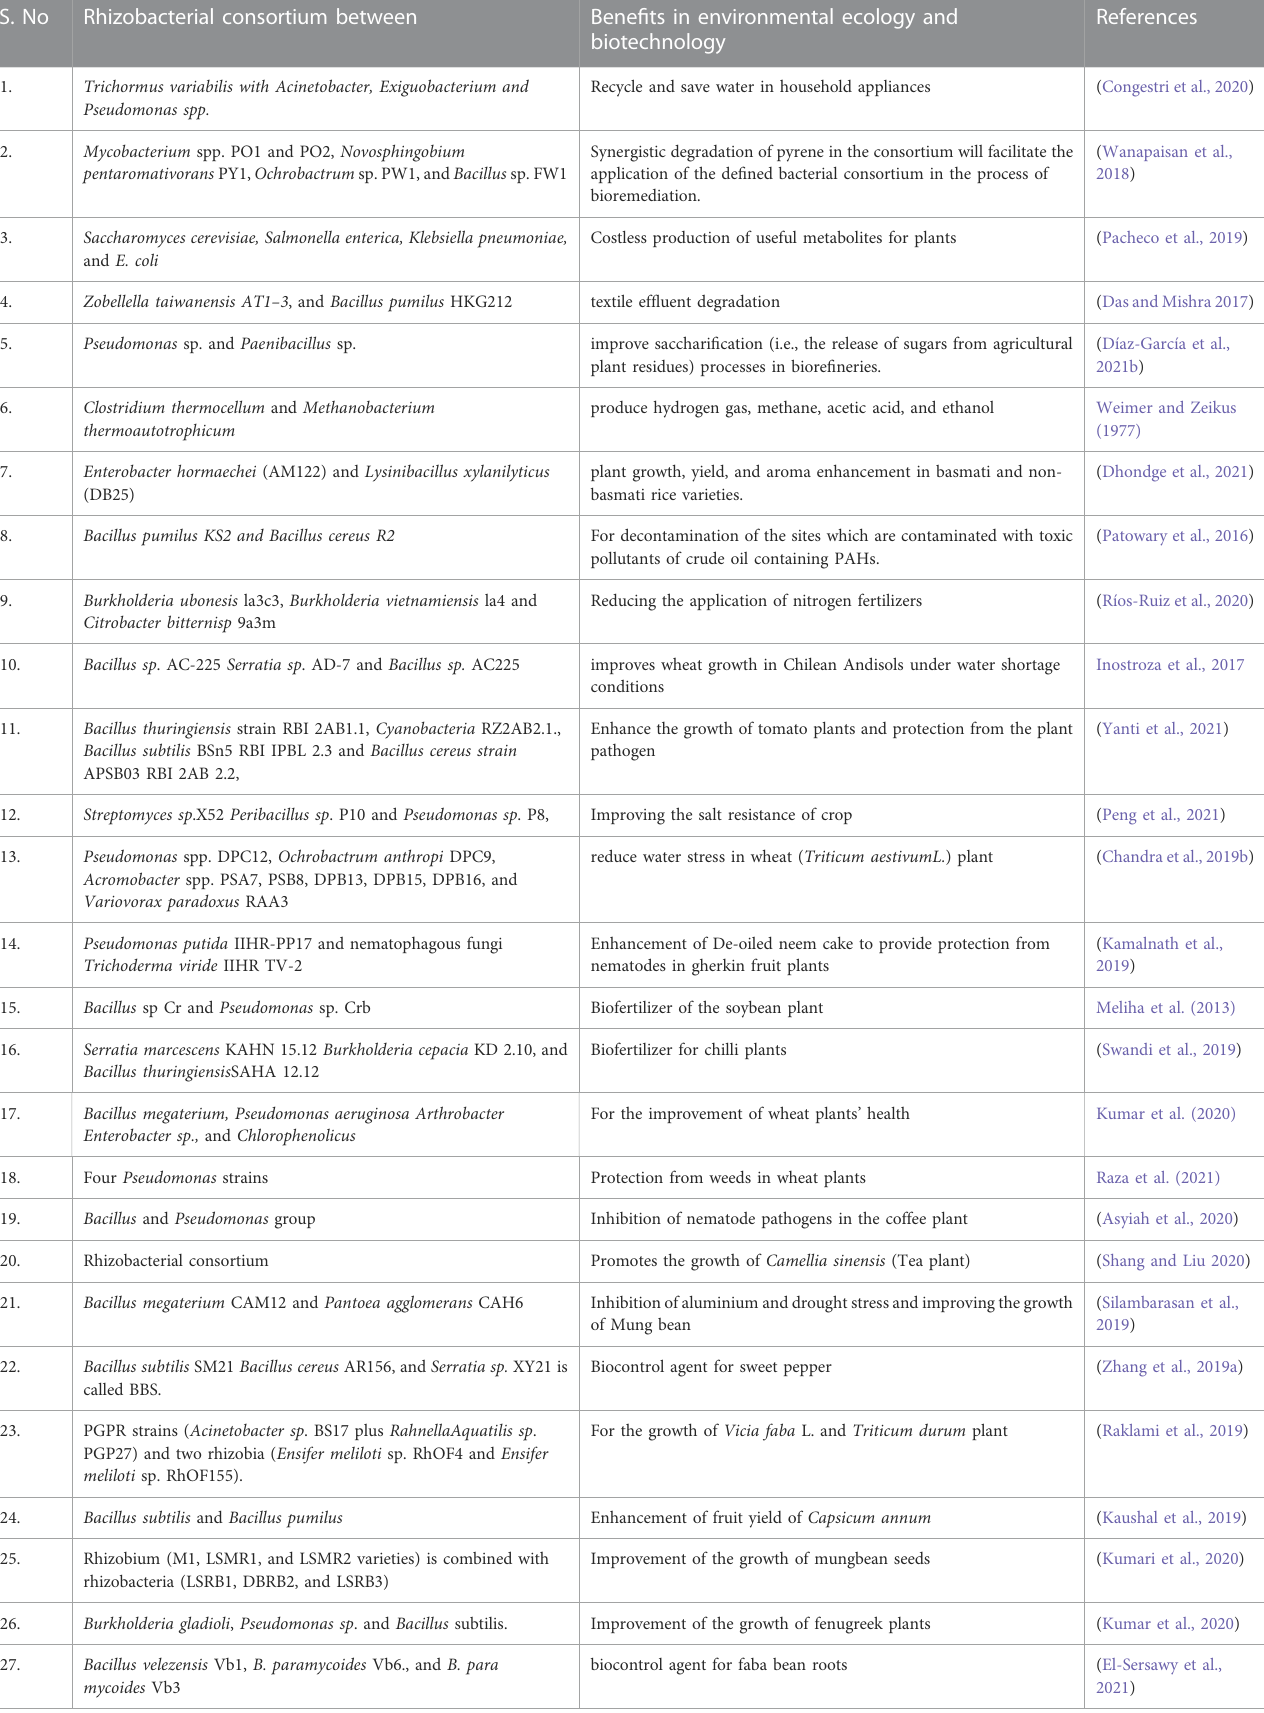
TABLE 2 Engineered rhizobacterial consortium and their applications in environmental ecology and